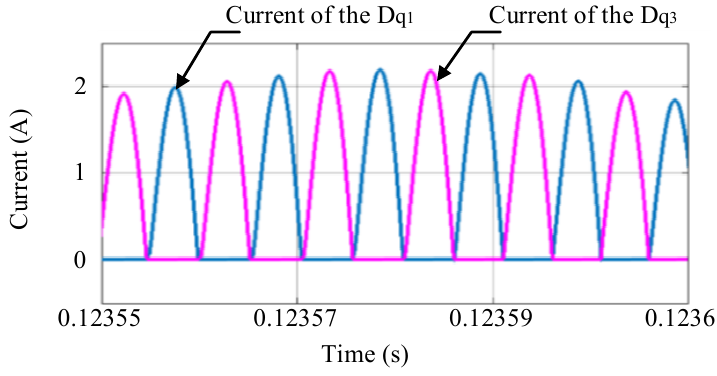
Figure 25. Current of D q1 and D q3 .